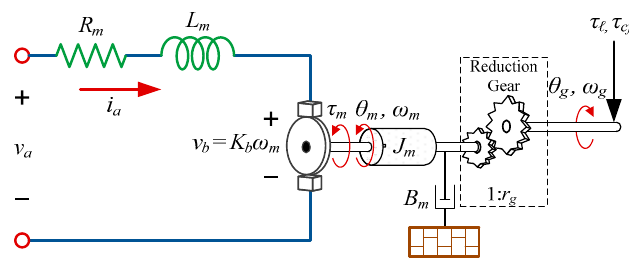
Figure 2. Electromechanical schematic for an armature-controlled PM DC motor.